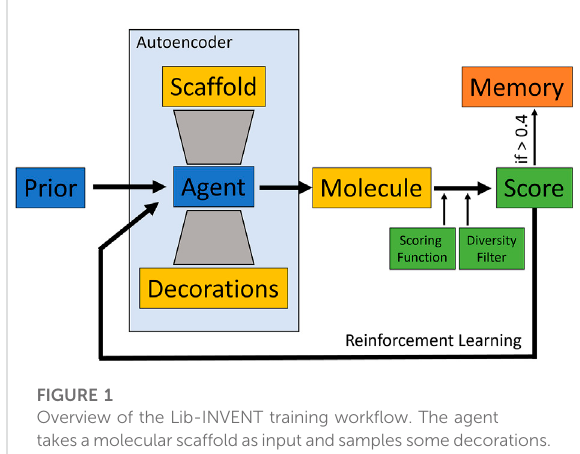
FIGURE 1 Overview of the Lib-INVENT training work fl ow. The agent takesamolecularscaffold asinputandsamplessomedecorations. Scaffold and decorations are then combined to form a molecule that is scored by the user-de fi ned scoring function. This score is then scaled down according to the desired diversity fi lter to obtain the fi nal score which is used to improve the model. If the score is above 0.4, the molecule is stored in memory (Fialkova et al., 2021).